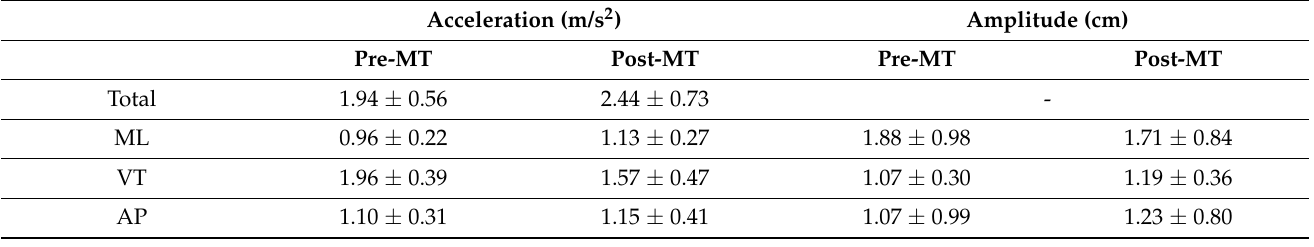
Table 2. Changes in acceleration and amplitude over the three axes (mediolateral (ML), vertical (VT), and anteroposterior (AP)) before and after music therapy (MT).